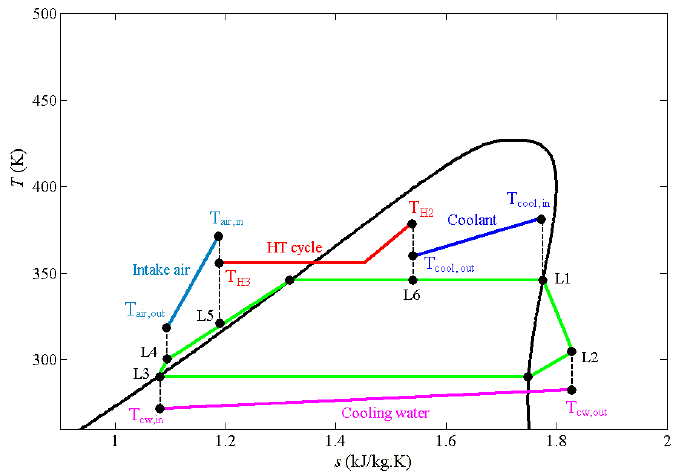
Figure 3. T-s diagram of the low-temperature (LT)